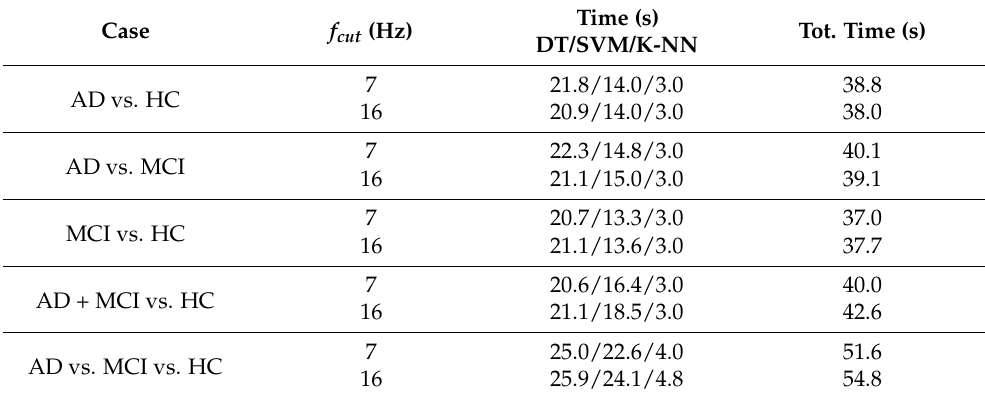
Table 2. Average execution time of the classification algorithm, including tuning of the